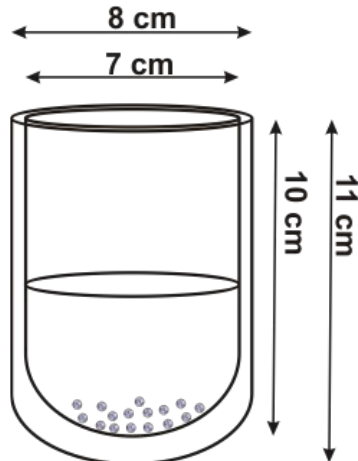
Figure 1. The geometrical parameters of the double-walled vessel used for the production of the spherical agglomerates.